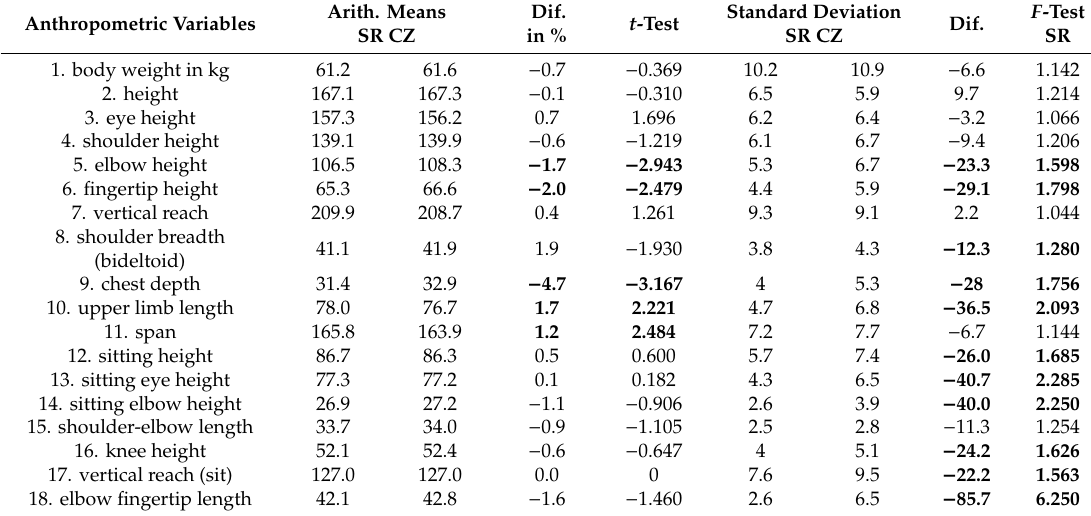
Table 2. Basic characteristics of anthropometric variables and their variation in the Slovak and Czech female population in the year